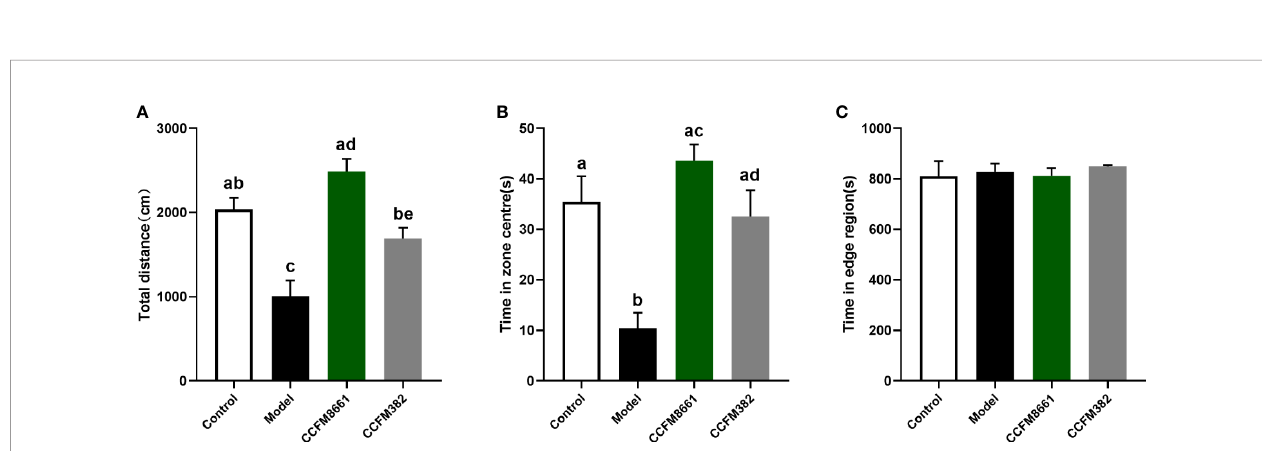
FIGURE 3 | Effects of L. plantarum CCFM8661 on B[ a ]P-induced behavioral changes. (A) The total distance, (B) The time spend in zone centres, (C) The time spend in edge region. The different letters indicate signi fi cant difference between groups ( P < 0.05